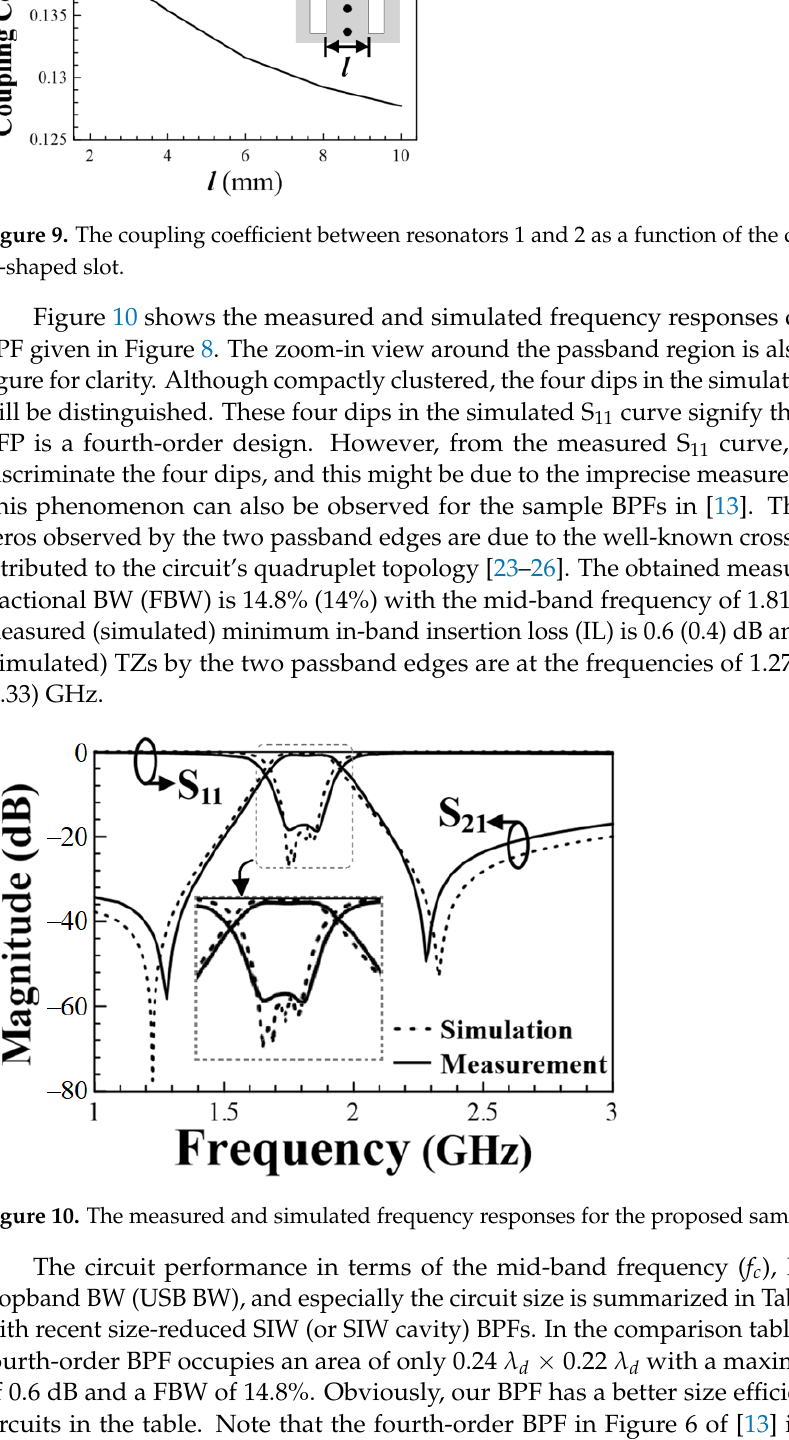
( c ) Figure 11. Photos of the experimental circuit: ( a ) the top view with one of the feeding SMAs; ( b ) the layer containing the coupling apertures; and ( c ) the side view.